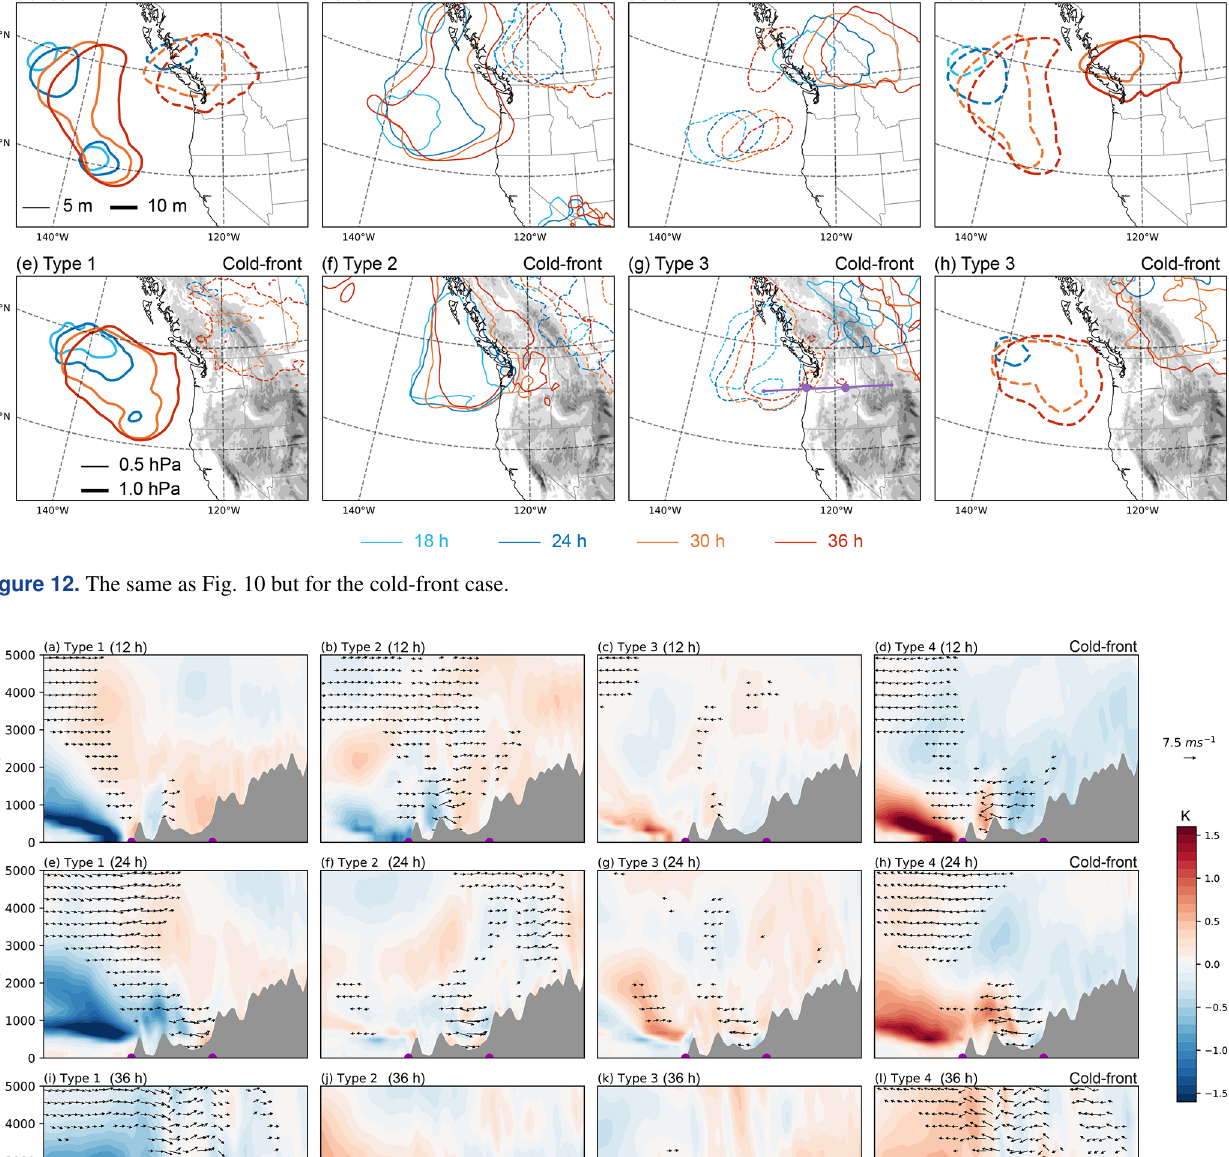
two periods influenced by typical weather systems. We uti- lize the WRFDA technique to generate initial perturbations based on NARR reanalysis, which is then used to initialize 48 h ensemble forecasts. The SOM technique is applied to characterize the major patterns in wind forecasting anoma- lies and associated IC